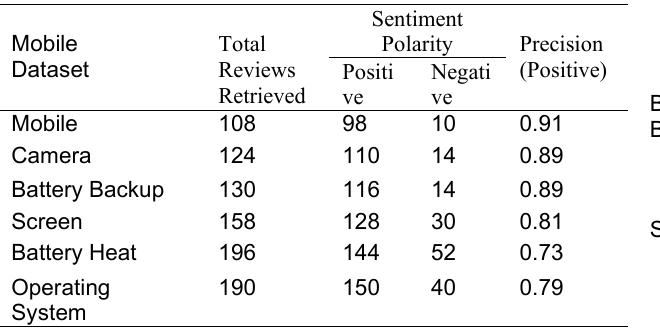
Table 5. Precision of FBA